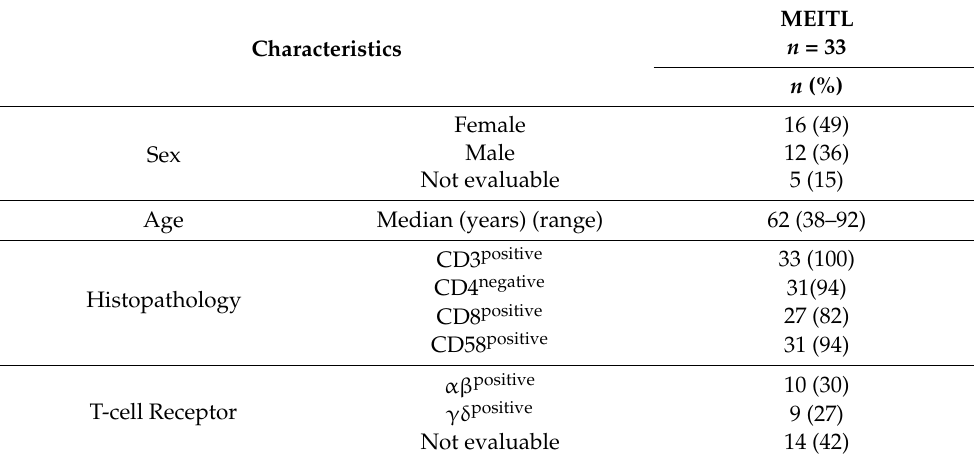
Table 1. Characteristics of mutation analysis